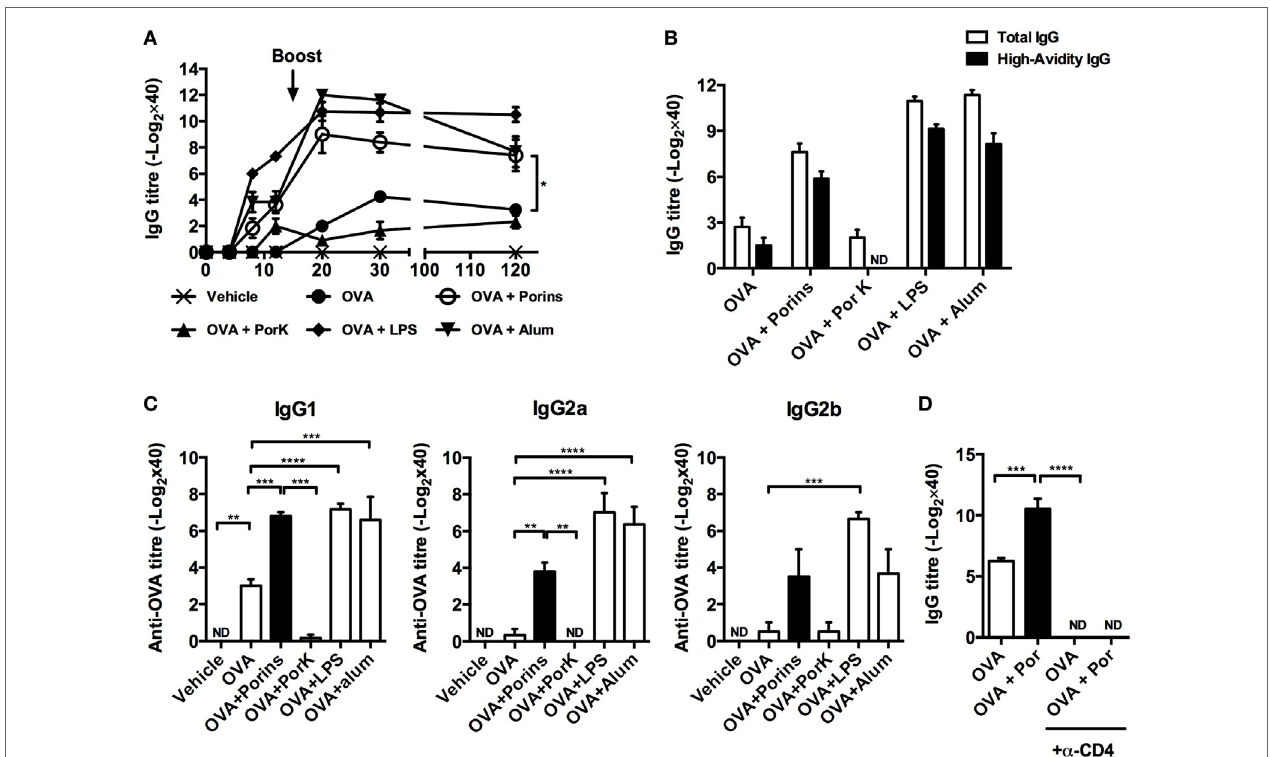
FigUre 1 | Ompc and OmpF from S . Typhi promote antibody responses to ovalbumin (OVa) . Four BALB/c mice per group were immunized i.p. with 100 μ g of OVA, OVA + 10 μ g of porins, OVA + 10 μ g of PorK, OVA + 5 μ g of LPS, or OVA + 100 μ g of alum. (a) Total IgG antibody responses were measured at the indicated time points by ELISA (B) high-avidity IgG and (c) IgG1, IgG2a, and IgG2b were measured at day 30 post-immunization. (D) BALB/c mice were injected i.p. with a depleting anti-CD4 mAb (GK1.5) 3 days prior to immunization with OVA or OVA + porins. GK1.5 mAb was given every 3 days thereafter until day 20, and the serum IgG and IgM responses were measured by ELISA. Mean + SEM are shown. These data are representative of three independent experiments. Statistical analysis was performed using one-way ANOVA with Bonferroni test post hoc . For panel (a) , Student’s t -test was performed comparing only OVA versus OVA + porins groups. Statistical differences are depicted as * P < 0.05, ** P < 0.01, *** P <